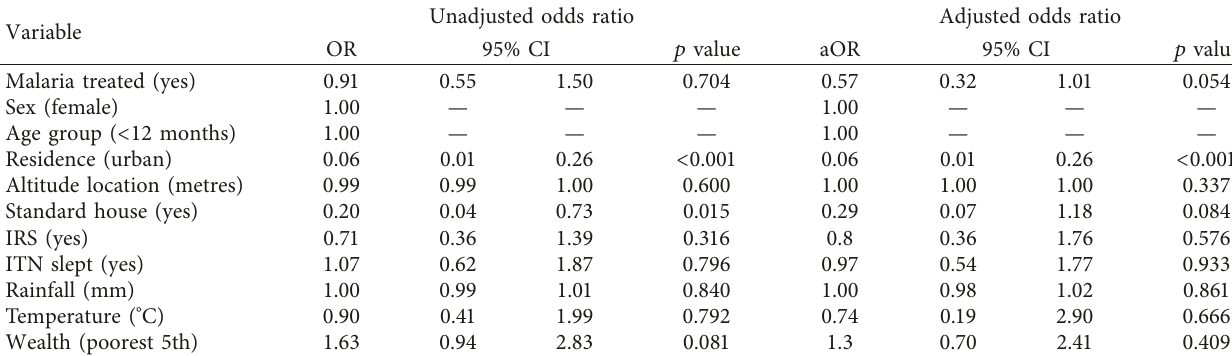
Table 4: Effect sizes of variables on prevalence using data from the high malaria endemic zone.